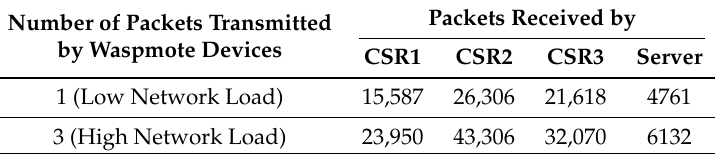
Table 7. Number of packets received by CSR devices and BLE server for each Waspmote device configuration in Individual Mesh with CSR devices retransmit each packet three